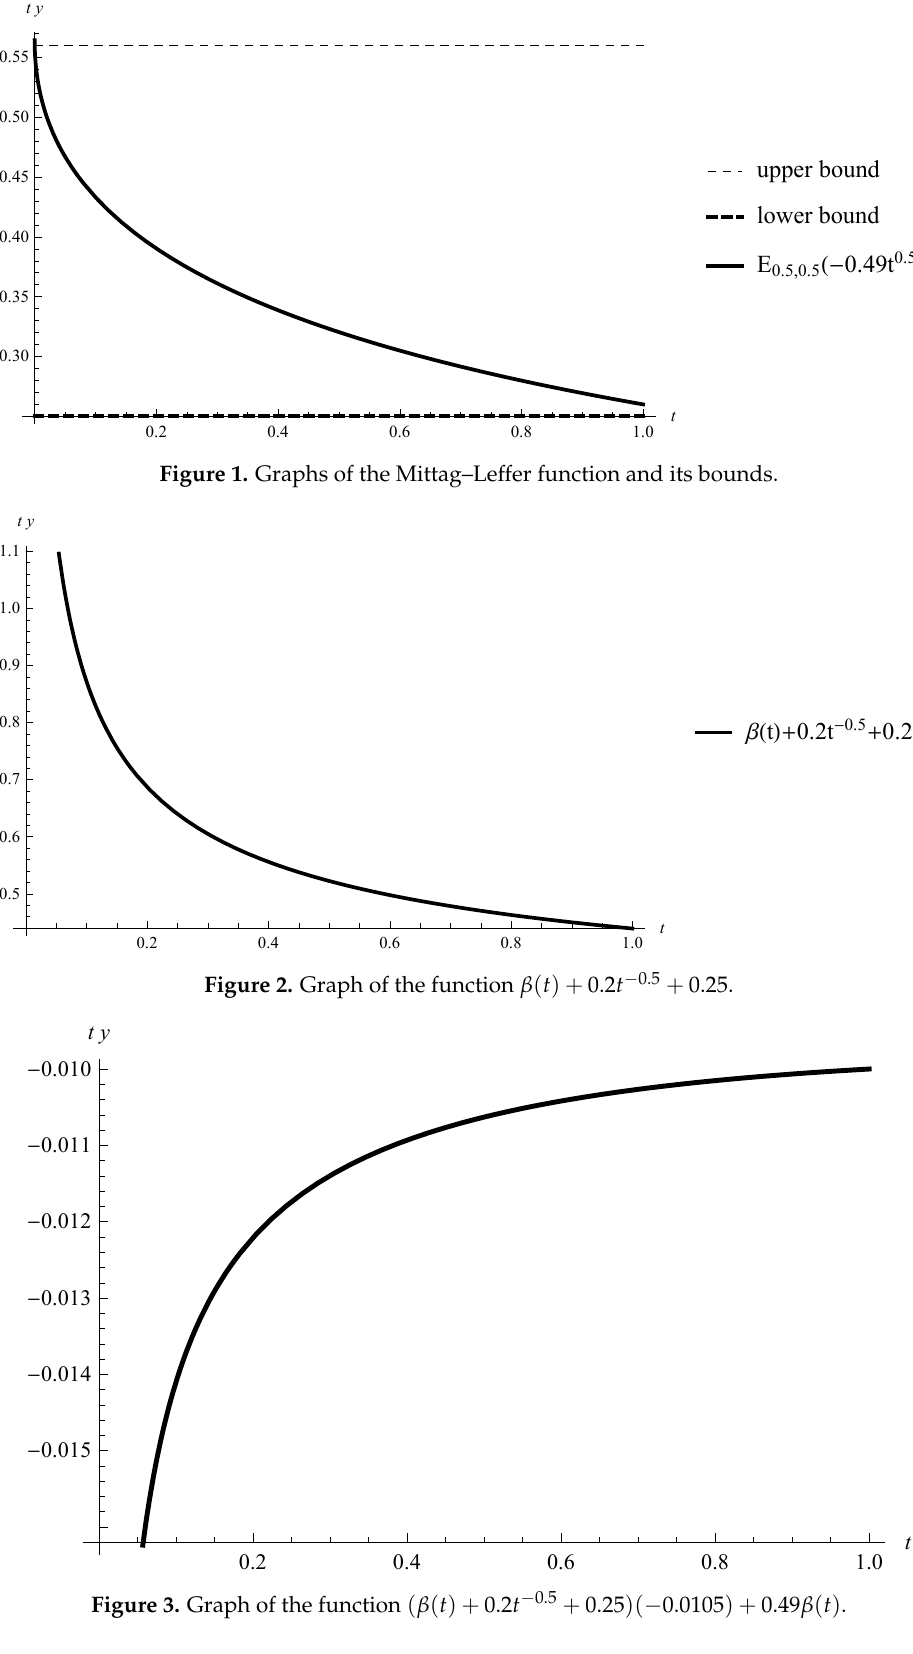
Figure 3. Graph of the function ( β ( t ) + 0.2 t − 0.5 + 0.25 )( − 0.0105 ) + 0.49 β ( t )